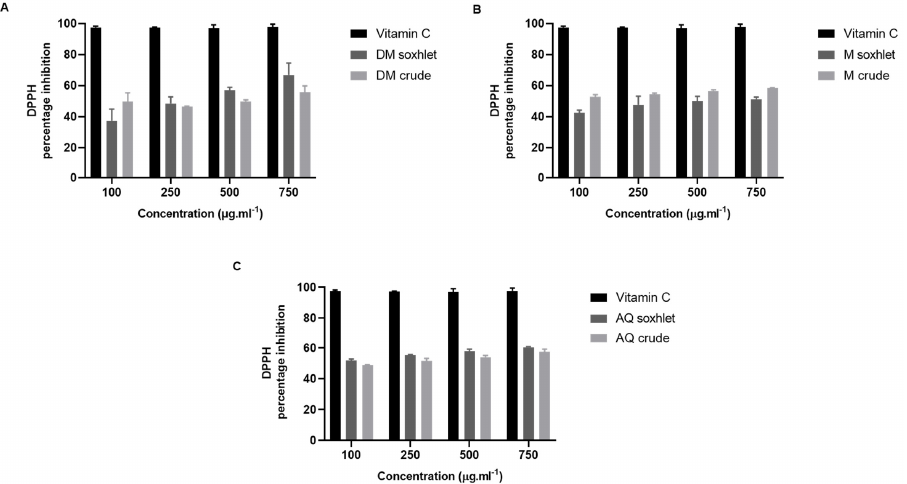
Figure 3. The antioxidant activity of J. rubens extracts: Determination of DPPH scavenging activity of different concentrations of J. rubens extracts (100, 250, 500, and 750 µg.mL −1 ). DPPH percentage inhibition of ( A ) DM extracts: DM Soxhlet and DM crude; ( B ) M extracts: M Soxhlet and M crude; ( C ) AQ extracts: AQ Soxhlet and AQ crude. Vitamin C was used as the standard. The absorbance was measured at 517 nm. Values are reported as the mean ± SD ( n = 3). DM: